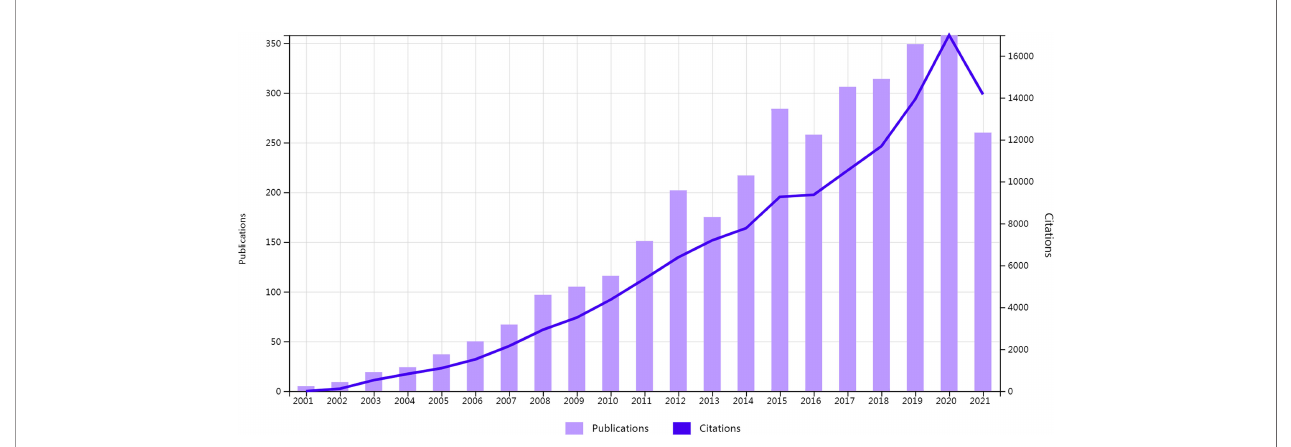
FIGURE 2 | Temporal distribution map of publications and